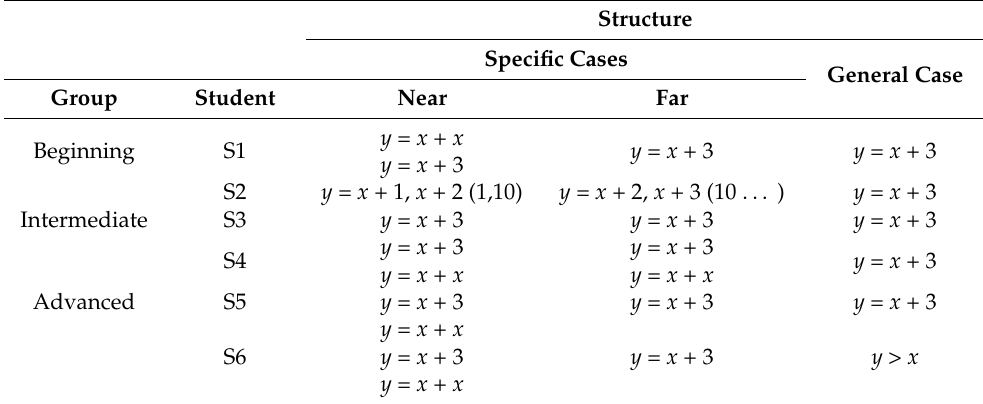
Table 2. Structures recognized by students.